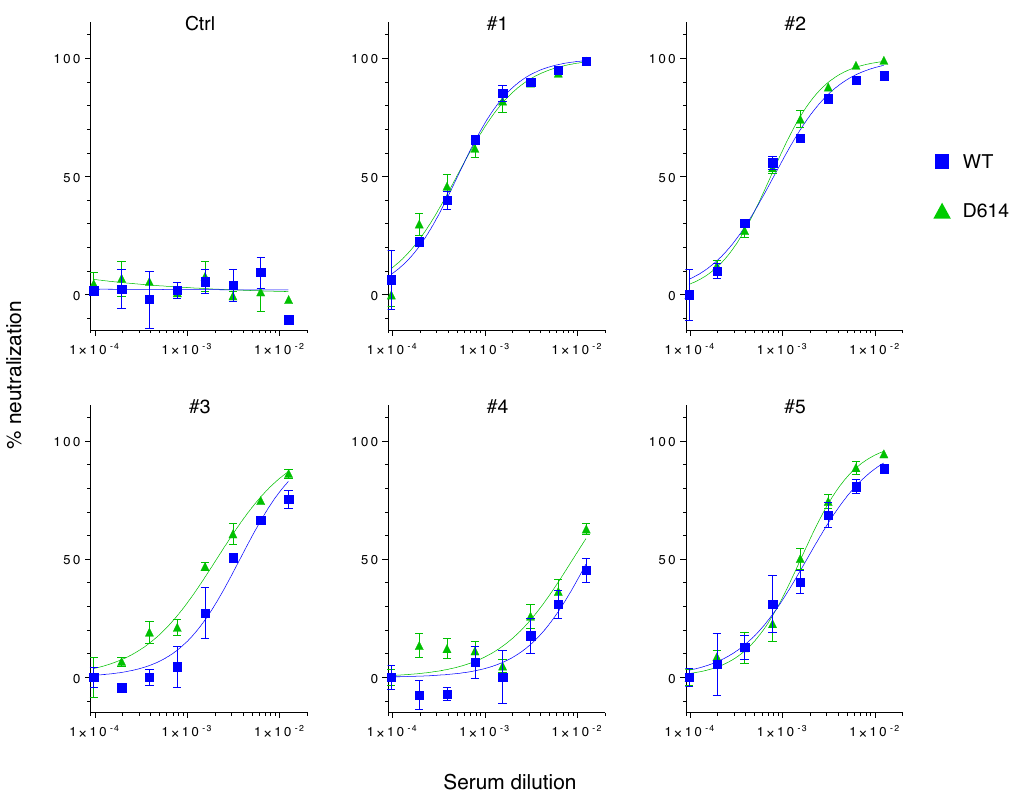
Fig. 5 SARS-2 S WT and D614G proteins are similarly neutralized by patient sera. Lentiviruses pseudotyped with either the WT or D614G mutant SARS2-S were preincubated with two-fold serially diluted human sera (80-fold to 10, 240-fold) obtained from a healthy donor (Ctrl) or collected at 15 – 30 days post-symptom onset from con fi rmed case patients (#1 – #5) infected with the prototypic viruses. The mixture was used for infection of 293T cells coexpressing ACE2 and TMPRSS2, and cell entry levels of pseudoviruses in the presence of diluted patient sera were determined by luciferase assays. Representative data from two independent experiments are shown as percent neutralization (mean ± s.d., n = 3 technical replicates). Source data are provided as a Source Data fi